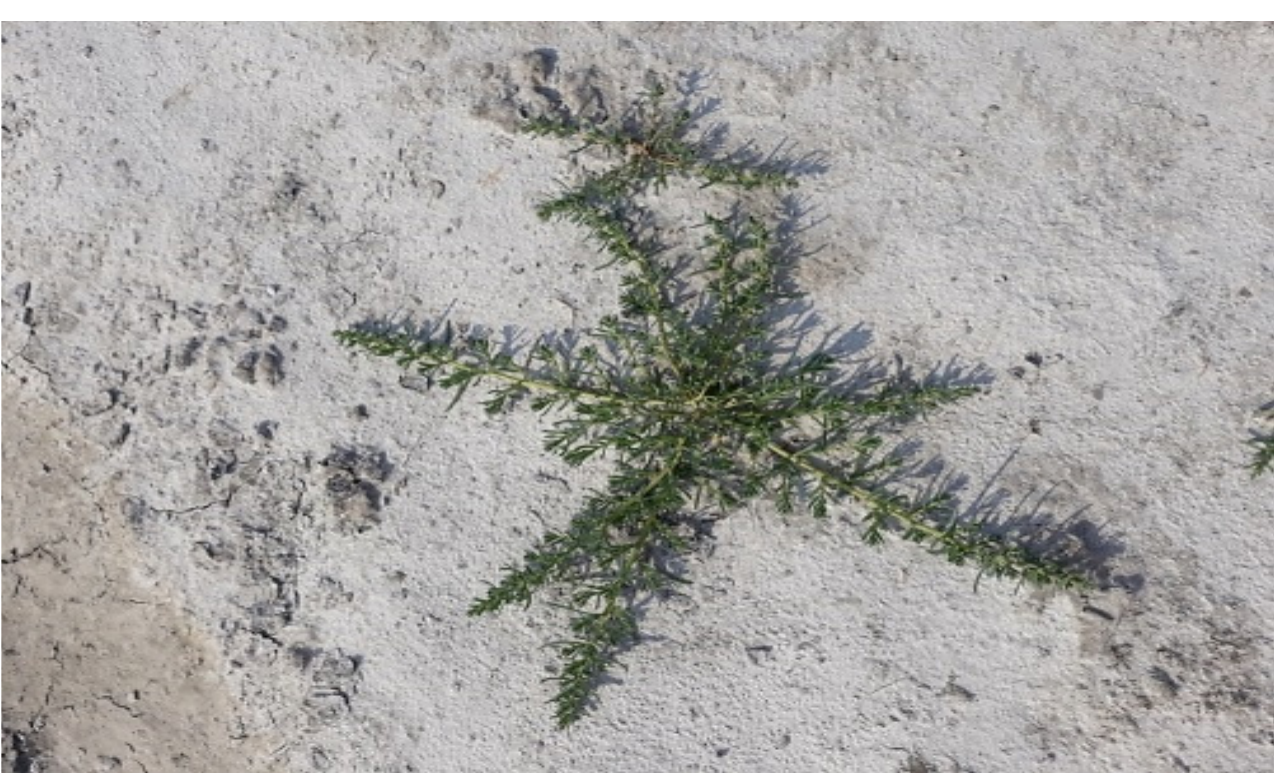
FIGURE 4 - Salsola soda